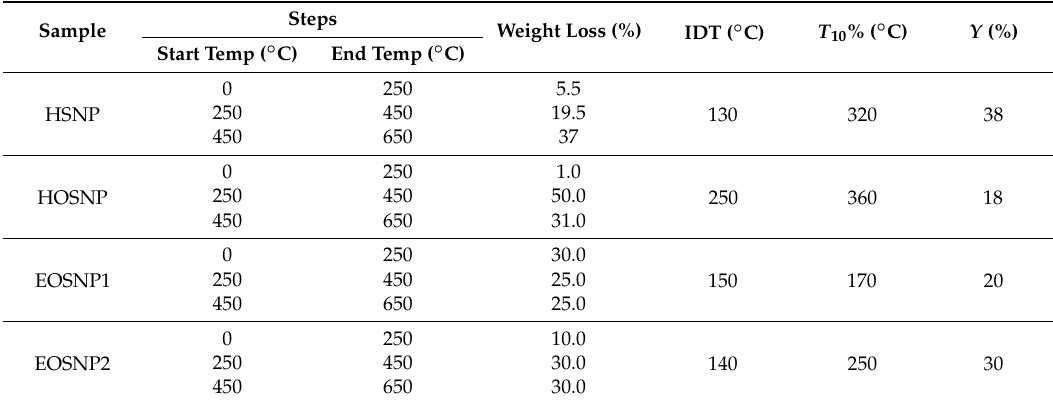
Table 2. Thermogravimetric analysis (TGA) data of the SNPs coated with